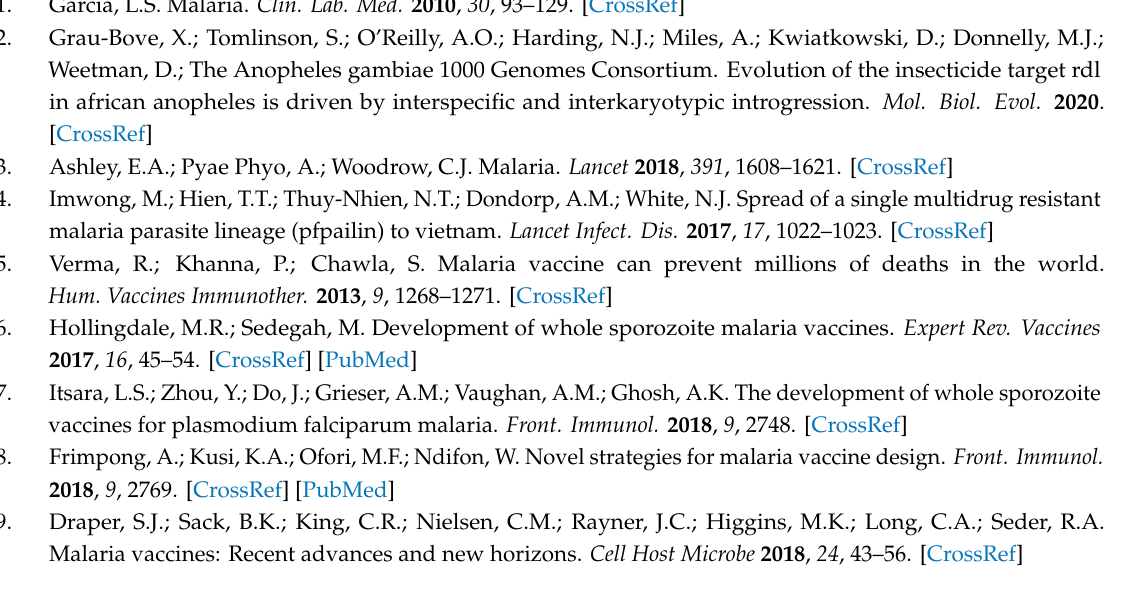
Figure S1. Treatment with anti-malaria drug artesunate (Art). Left panel: protocol of experiment. Infection with 50,000 parasitized red blood cells (pRBCs) were performed on day 0, Art (64 mg / kg body weight / day) was administered i.p. from day 10 to day 15 post-infection. Right panel: change of parasitemia. Each line indicates one mouse (N = 6). Figure S2. Flow cytometry gating strategy. Organs from uninfected or PyNL-infected mice were harvested at day 20 and dissociated to single cell suspensions, Fc blocked then stained with indicated the antibody cocktails. Surface staining dead cells were then stained with zombie dye, as described in the Materials and Methods. The flow cytometry analysis gating strategy is shown. Spleen cells without RBC lysis are used as an example, the same gate was used for all samples. ( A ) FSC vs SSC plot. Cell debris is excluded from analysis. ( B ) Gated populations in A were further gated for single cells by FSC-A vs FSC-H. ( C ) Gated populations in B were further gated for live cells, then used for analysis in Figure